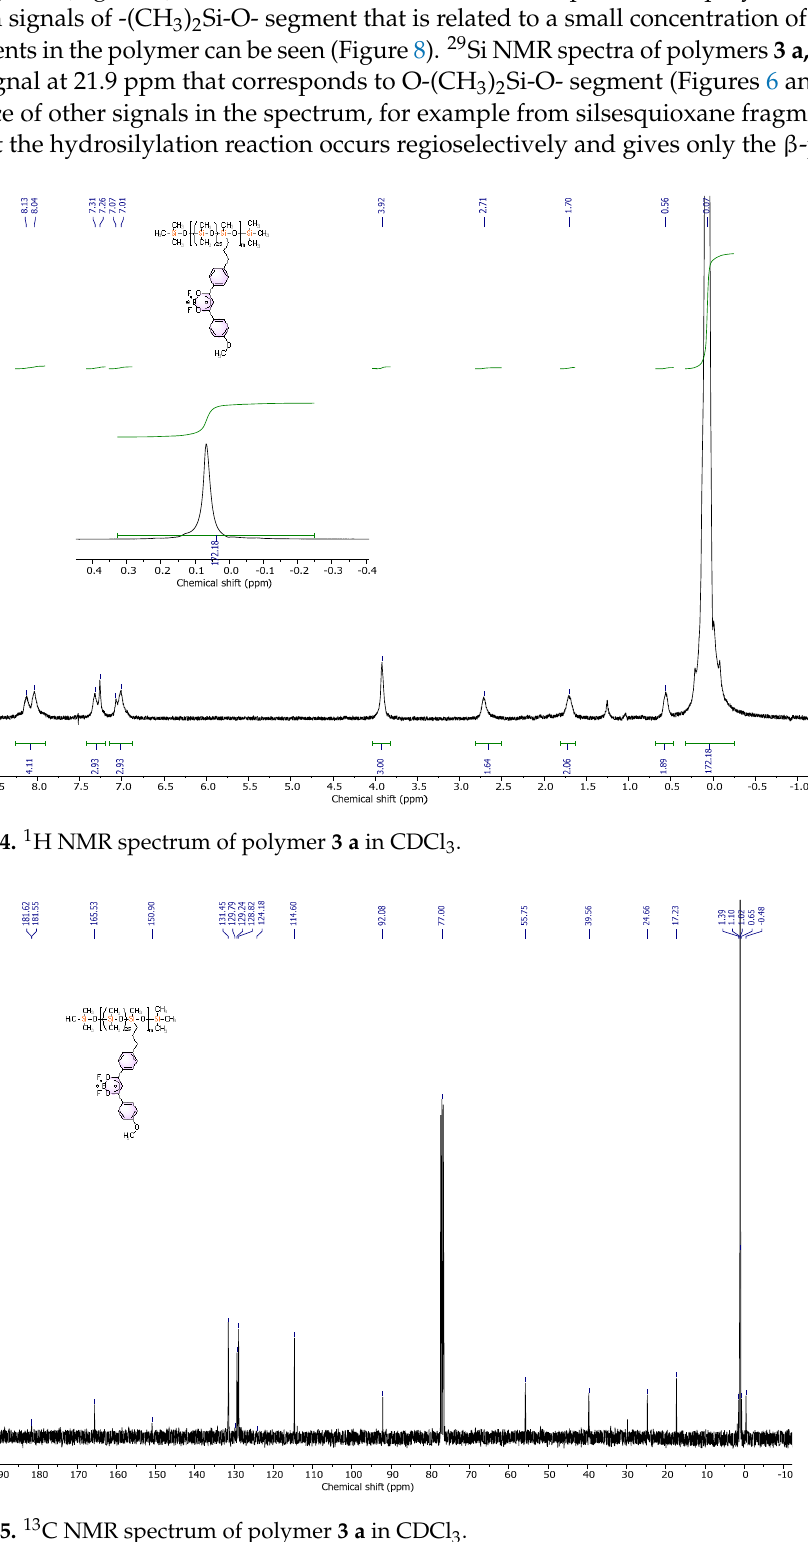
Figure 6. 29 Si NMR spectrum of polymer 3 a in CDCl 3 .